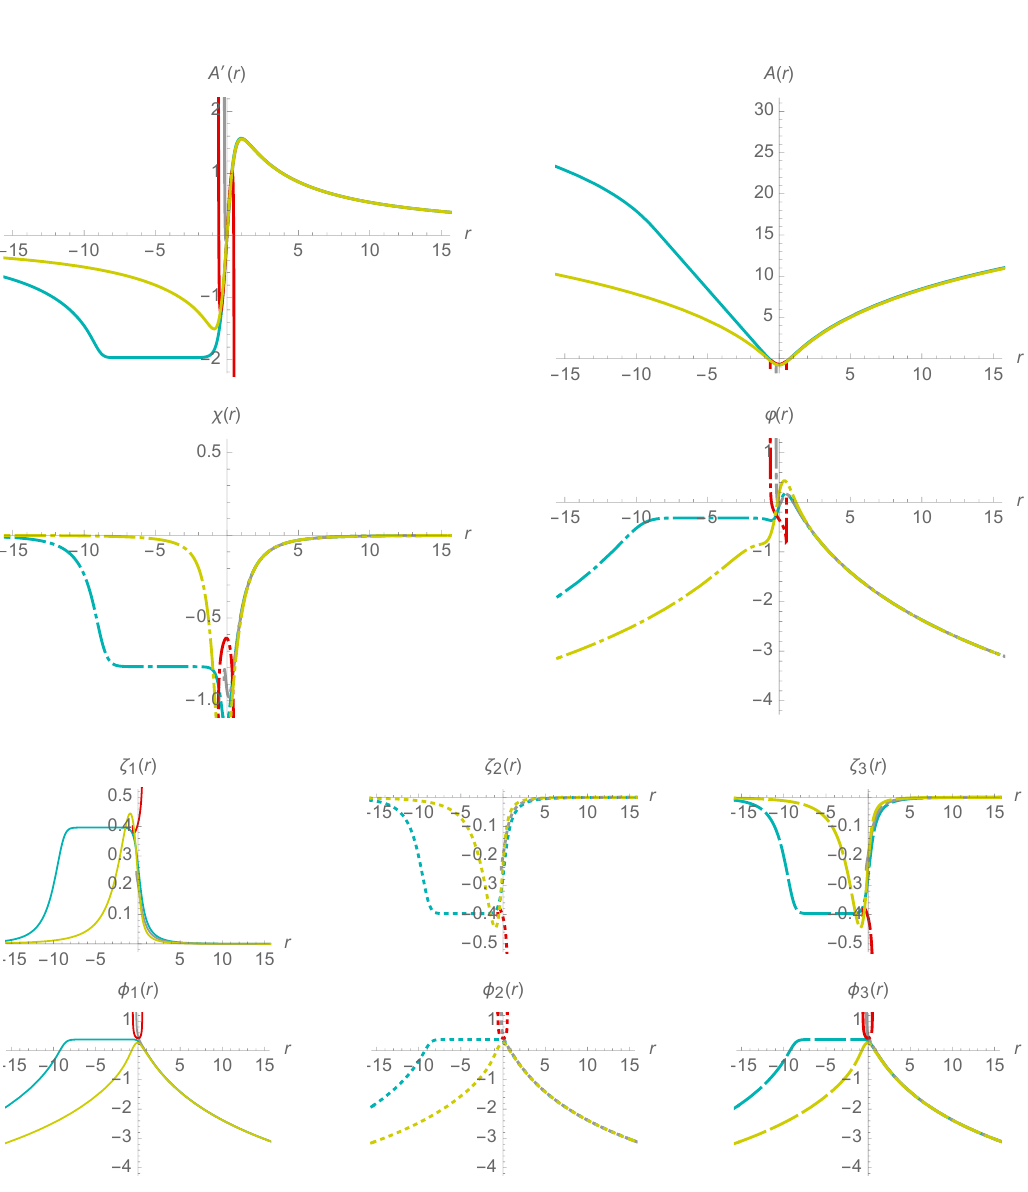
Figure 2. Examples of supersymmetric Janus solutions interpolating between N = 8 SYM (yellow), N = 8 SYM and SO(4) AdS 4 (light blue), N = 8 SYM and a singulary (grey), and between singularities